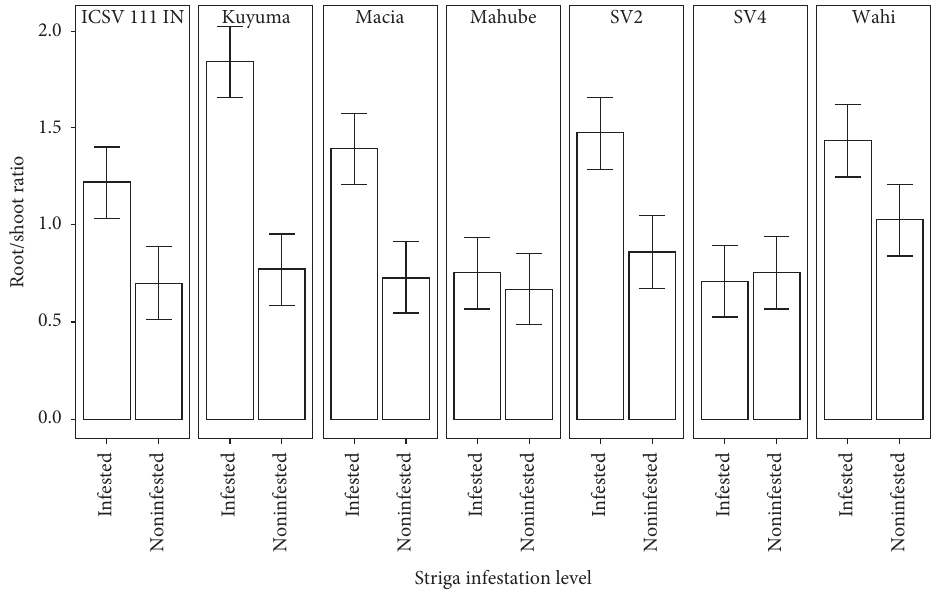
Figure 10: Effect of genotype and S. asiatica infestation on sorghum root to shoot ratio. Error bars represent LSD at p < 0 .